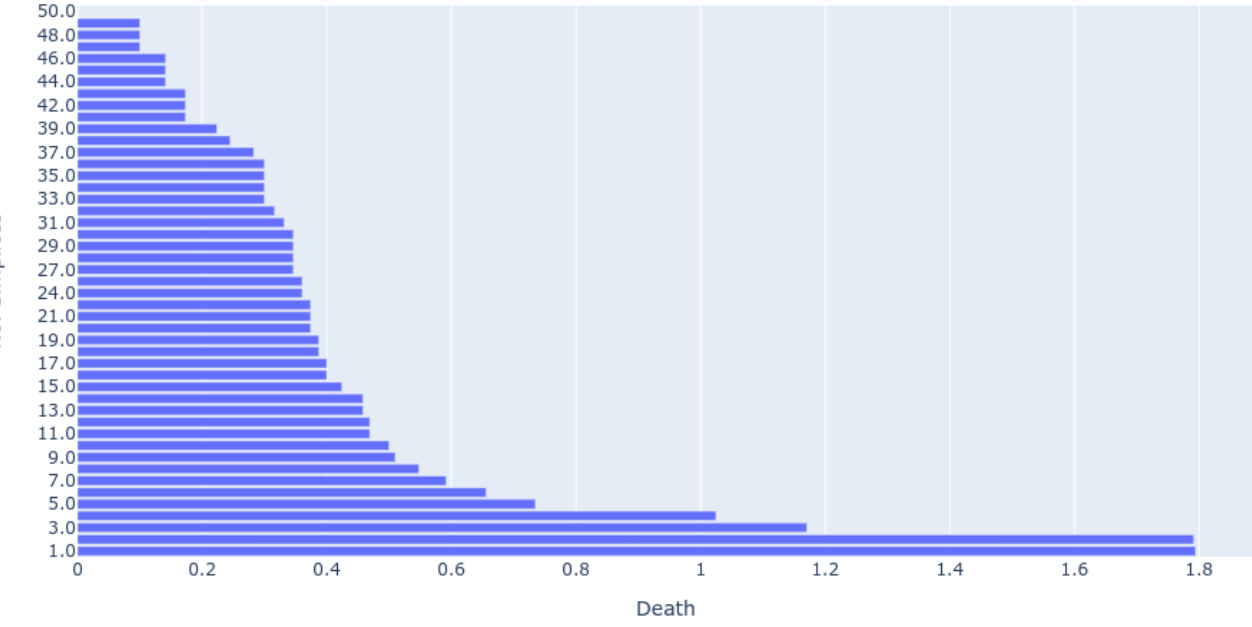
Figure 10. Bar Code result from 0-dimensional Homology analysis in STM32F767 Nucleo-144 plat- form. The analysis was obtained by randomly sampling 64 samples from the IRIS